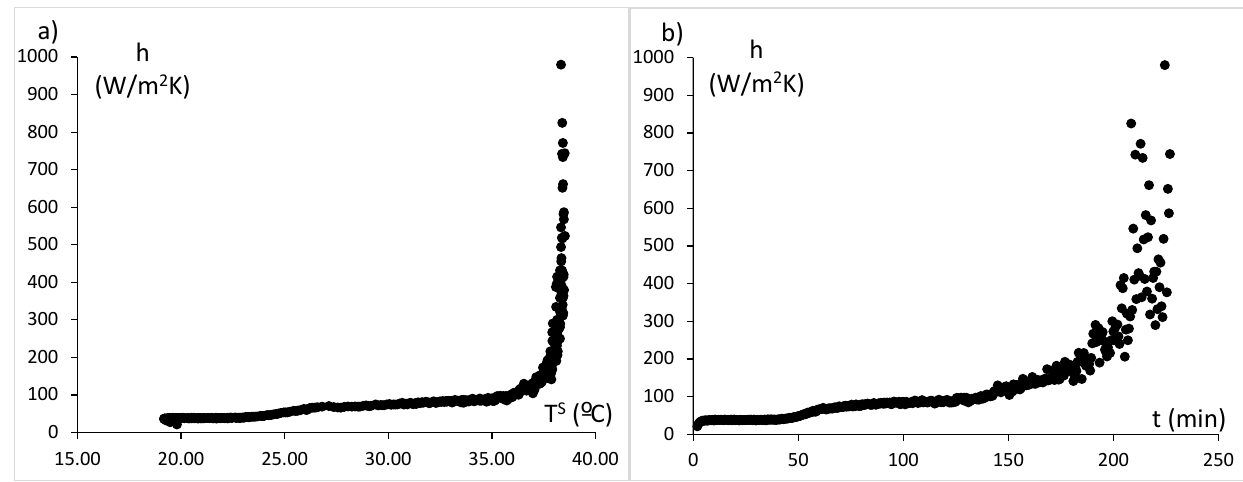
Figure 5. The individual coefficient of heat convection with regard to ( a ) surface temperature in the HAD treatment and ( b ) drying time.